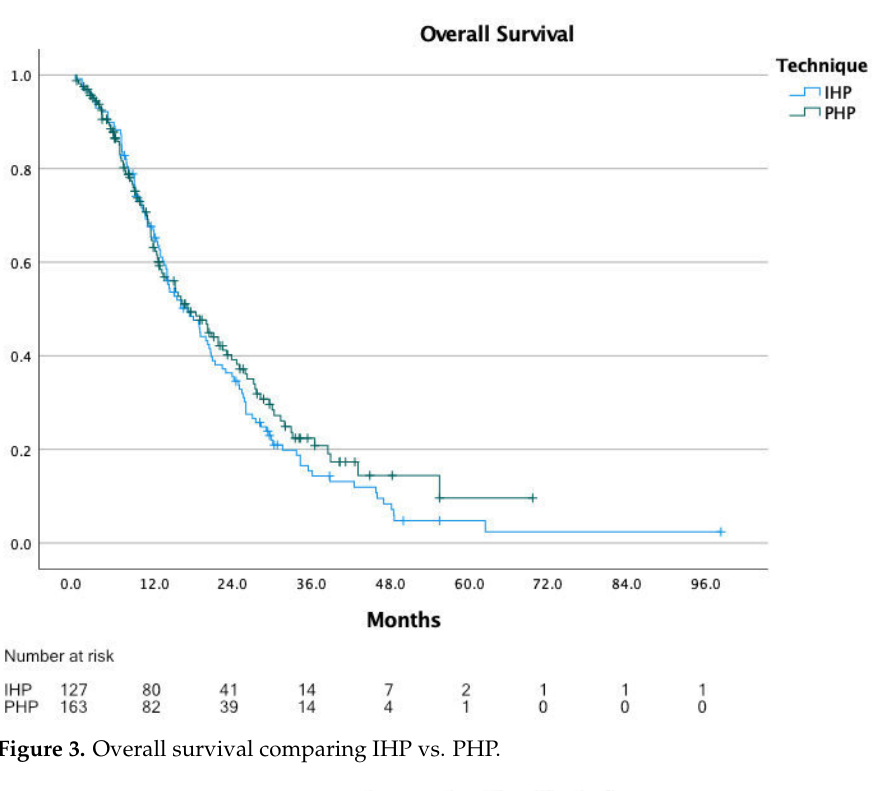
Figure 2. Overall survival per study.